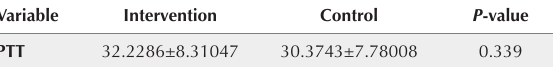
Table 3. Mean (standard deviation) partial thromboplastin time in intervention and control groups Variable Intervention Control